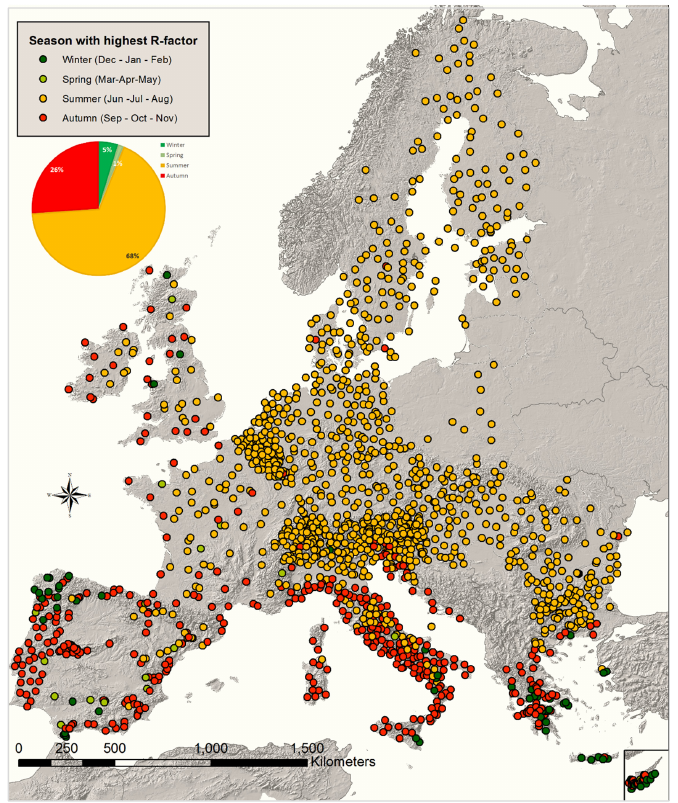
Figure 5. Spatial distribution of largest seasonal R-factor values in REDES.